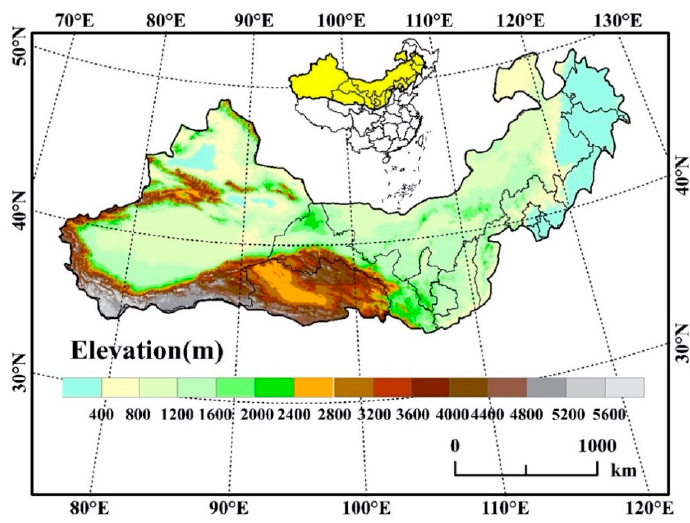
Figure 1. Location of the northern